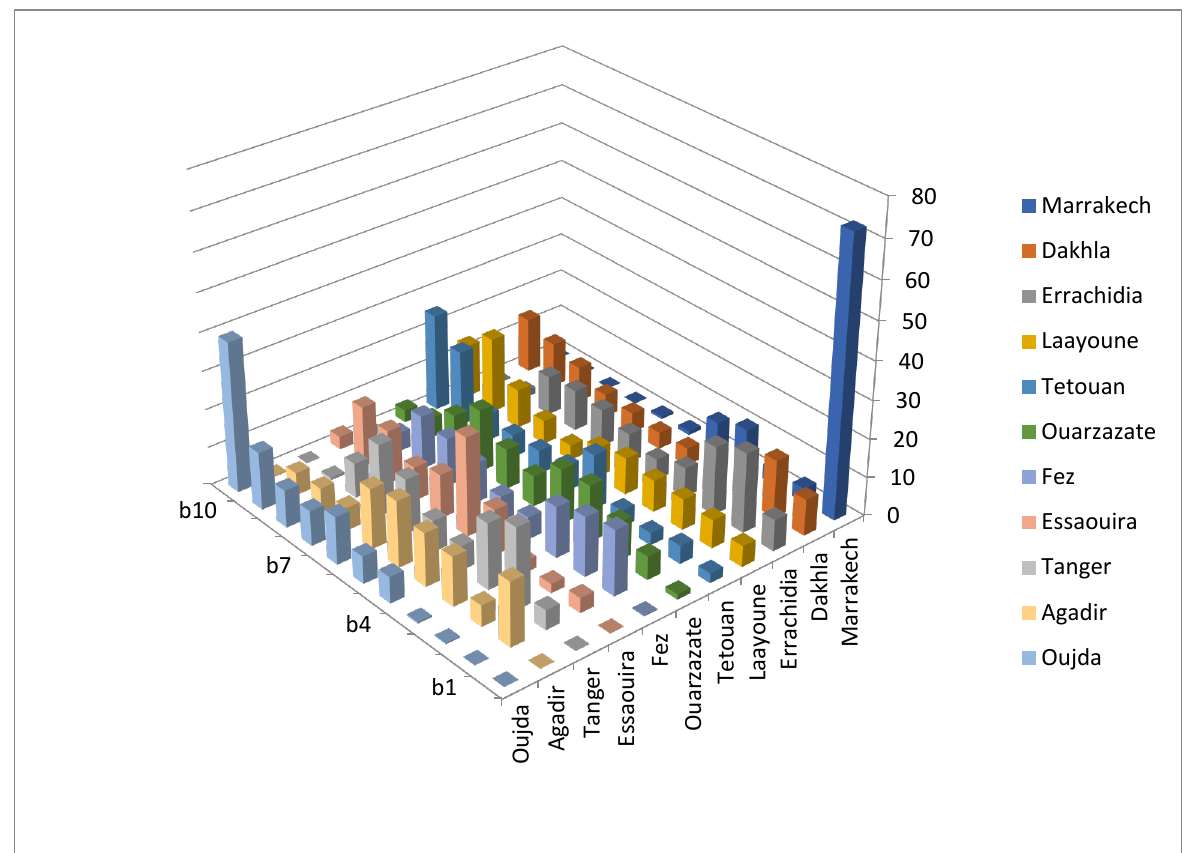
Figure 6. Second analysis with electricity consumption as the new criterion. Rank acceptability indices for the alternatives sorted according to their acceptability indices.